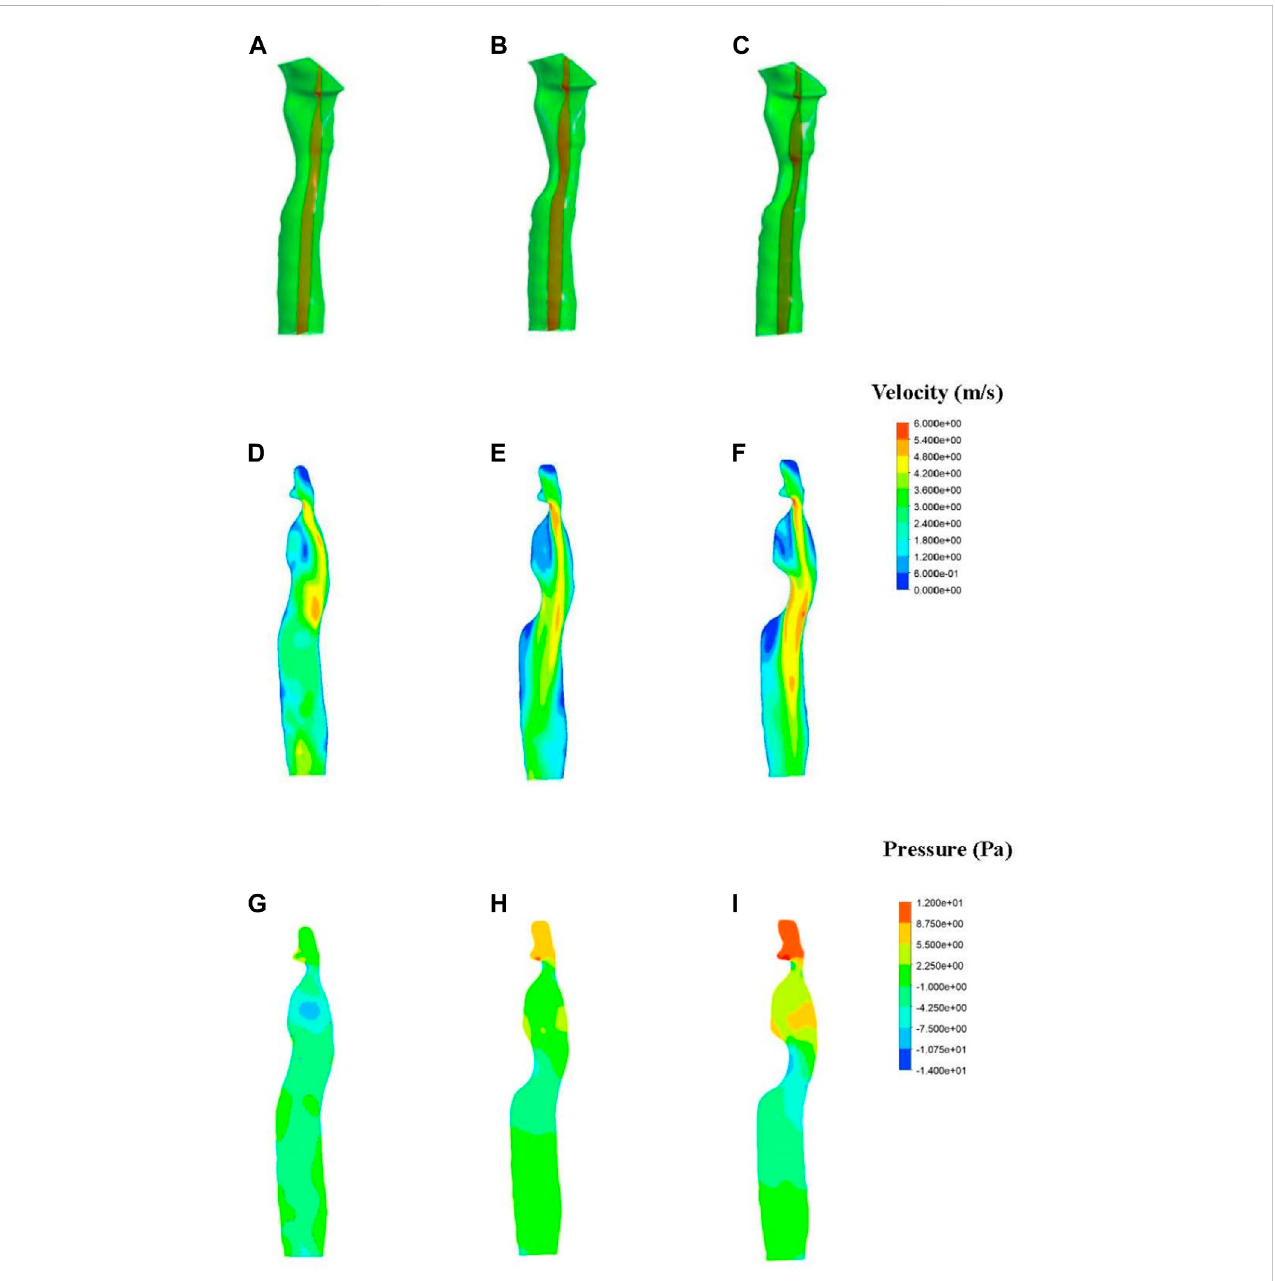
FIGURE 5 Fluid simulations associated with patient one. (A – C) Section position (shown in red). (D – F) Contours of velocity distribution. (G – I) Contours of pressure